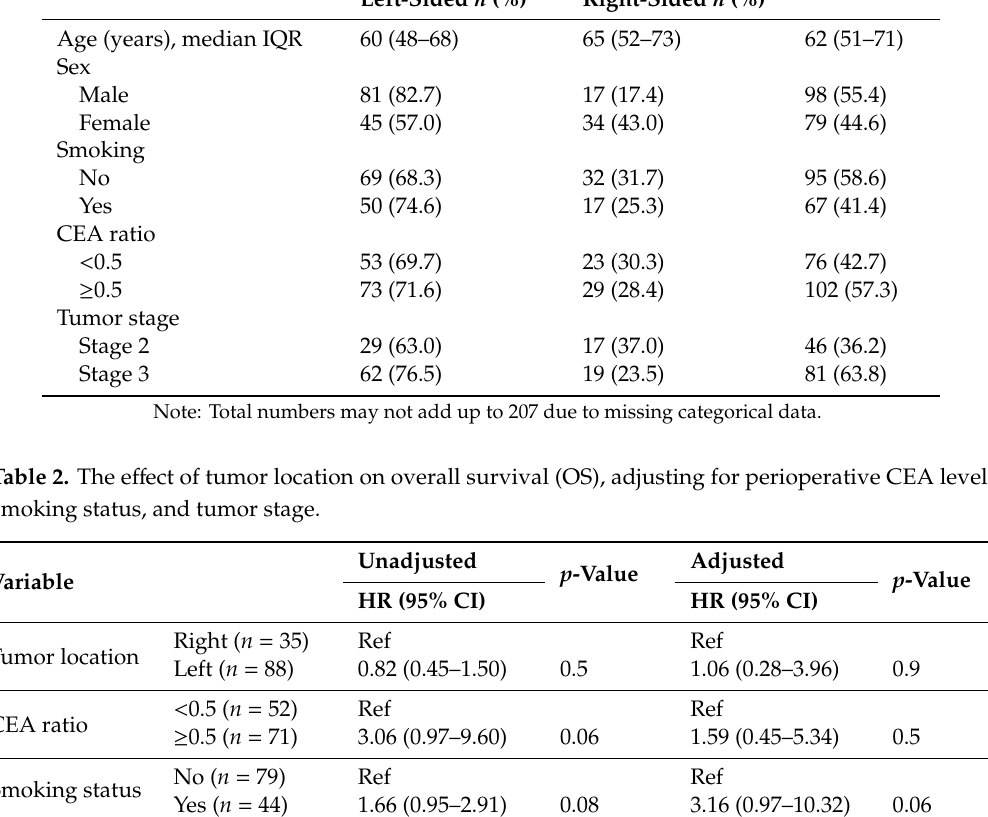
Figure 3. Kaplan–Meier survival based on tumor location among those with CEA > 5 at the time of recurrence. Table 1. Tumor location in patients categorized by age, sex, smoking status, CEA ratio, and tumor stage.